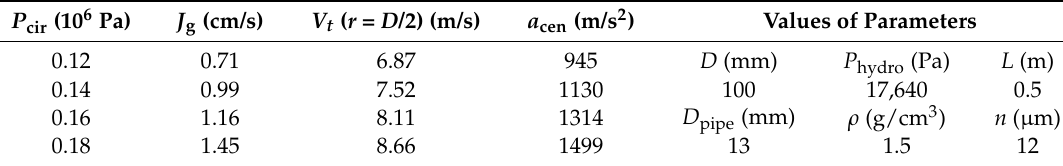
Table A2. Centrifugal force values under various circulation